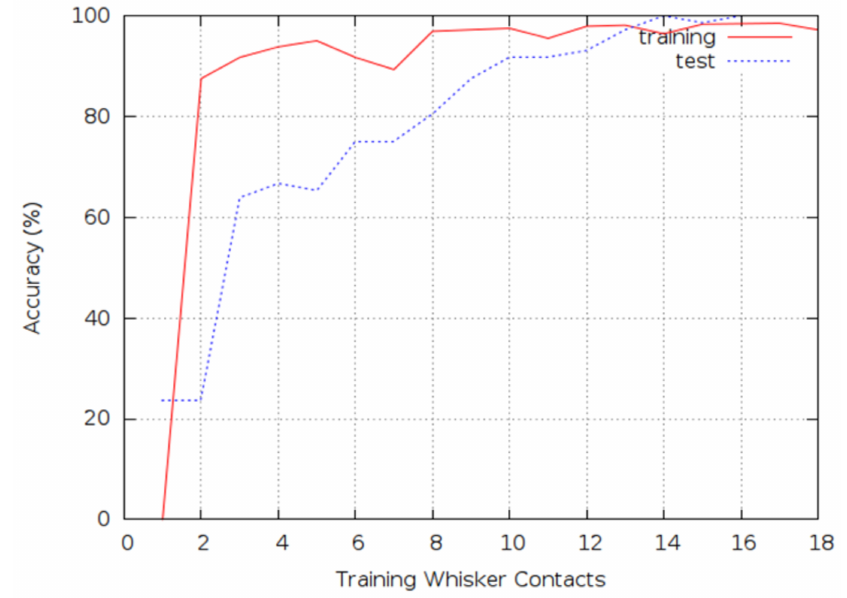
Figure 11. Classification accuracy for the training and test